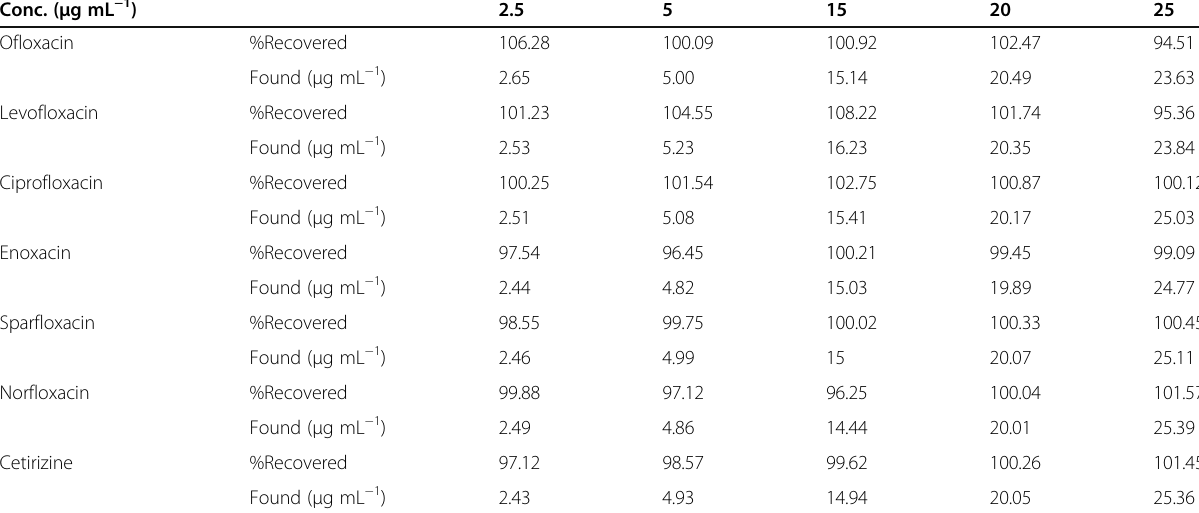
Table 5 %Recoveries in